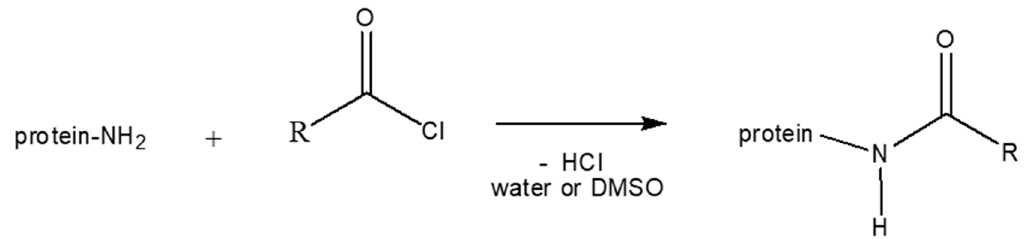
Figure 6. Schematization of Schotten–Baumann reaction. Table 4. Blends name and compositions.